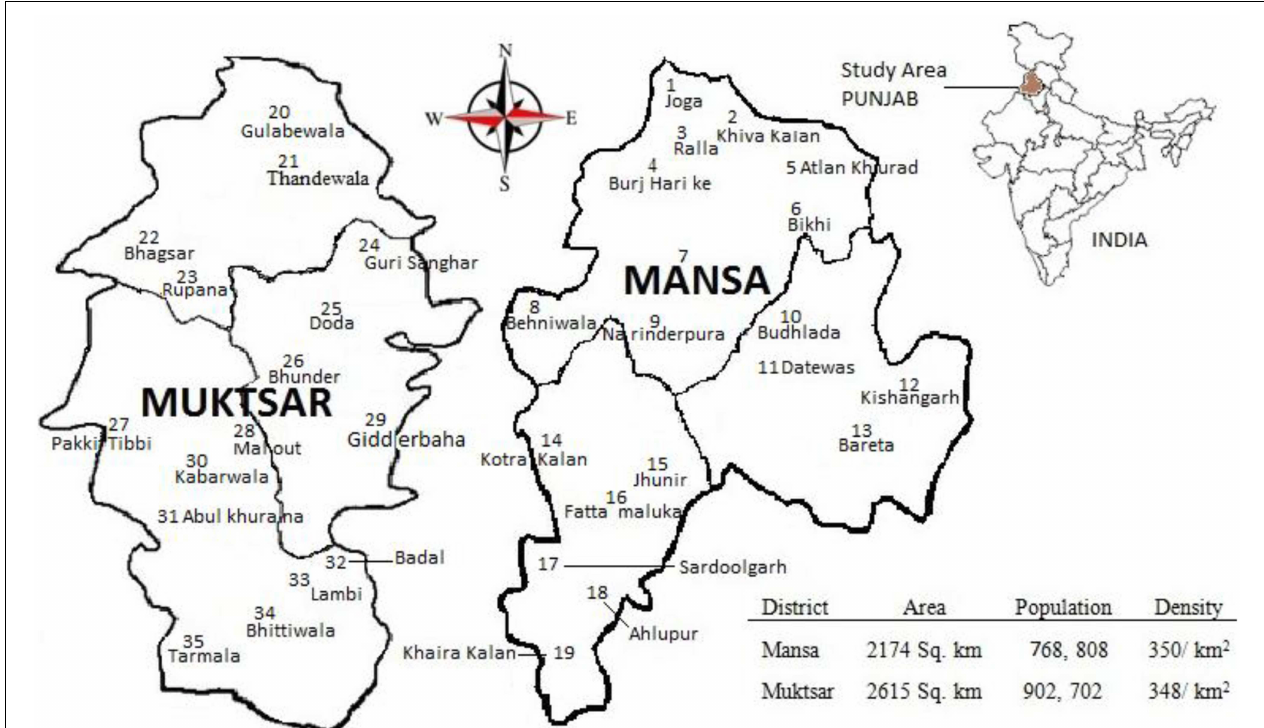
FIGURE 1 | Map of studied area in